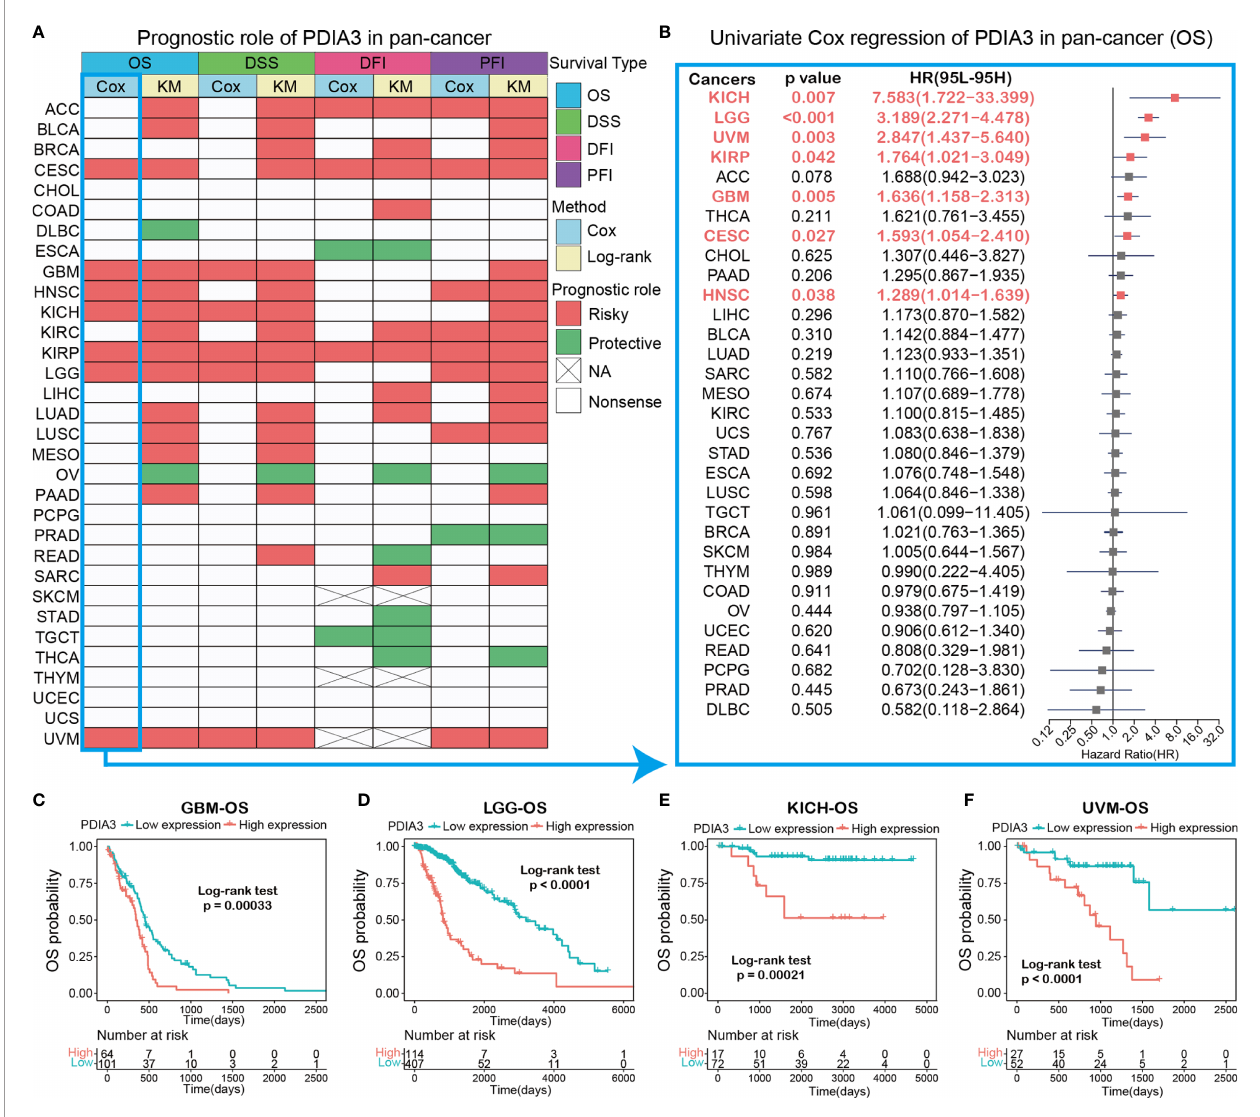
FIGURE 3 | (A) Summary of the correlation between expression of PDIA3 with overall survival (OS), disease-speci fi c survival (DSS), disease-free interval (DFI) and progression-free interval (PFI) based on the univariate Cox regression and Kaplan-Meier models. Red indicates that PDIA3 is a risk factor affecting the prognosis of cancer patients, and green represents a protective factor. Only p values < 0.05 are shown. (B) The forest plot exhibited the prognostic role of PDIA3 in cancers by univariate Cox regression method. The cancer type in red represents the PDIA3 acts as a risky factor with statistical signi fi cance. (C – F) Kaplan-Meier overall survival curves of PDIA3 in GBM (C) , LGG (D) , KICH (E) and UVM (F)